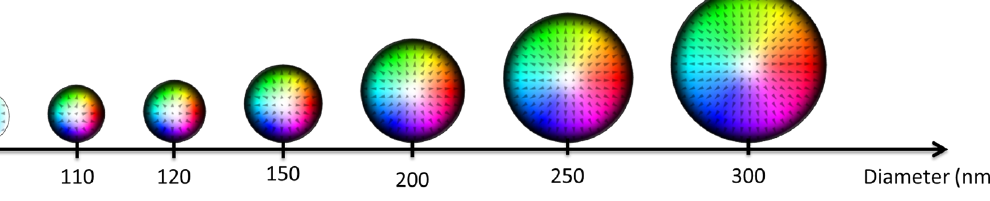
Figure 4. Static configurations for various diameters of nanodots. The calculation parameters are: dot thickness = 1.4 nm, M = 1220 emu/cm 3 , K = − 1.04 erg/cm 3 , D = − 1.34 erg/cm 2 , A = 1.6 µ erg/cm.